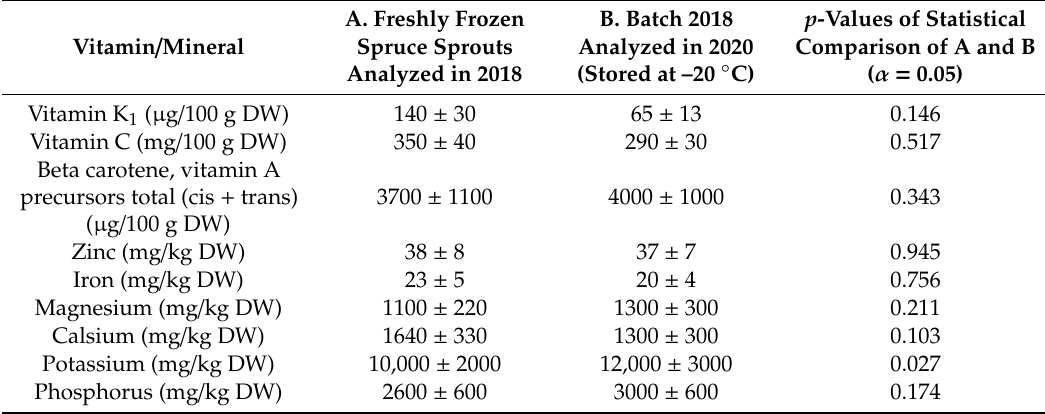
Table 3. Stability of vitamins and minerals of spruce sprouts (x ± standard deviation (SD)) during two-year storage at 20 °C.